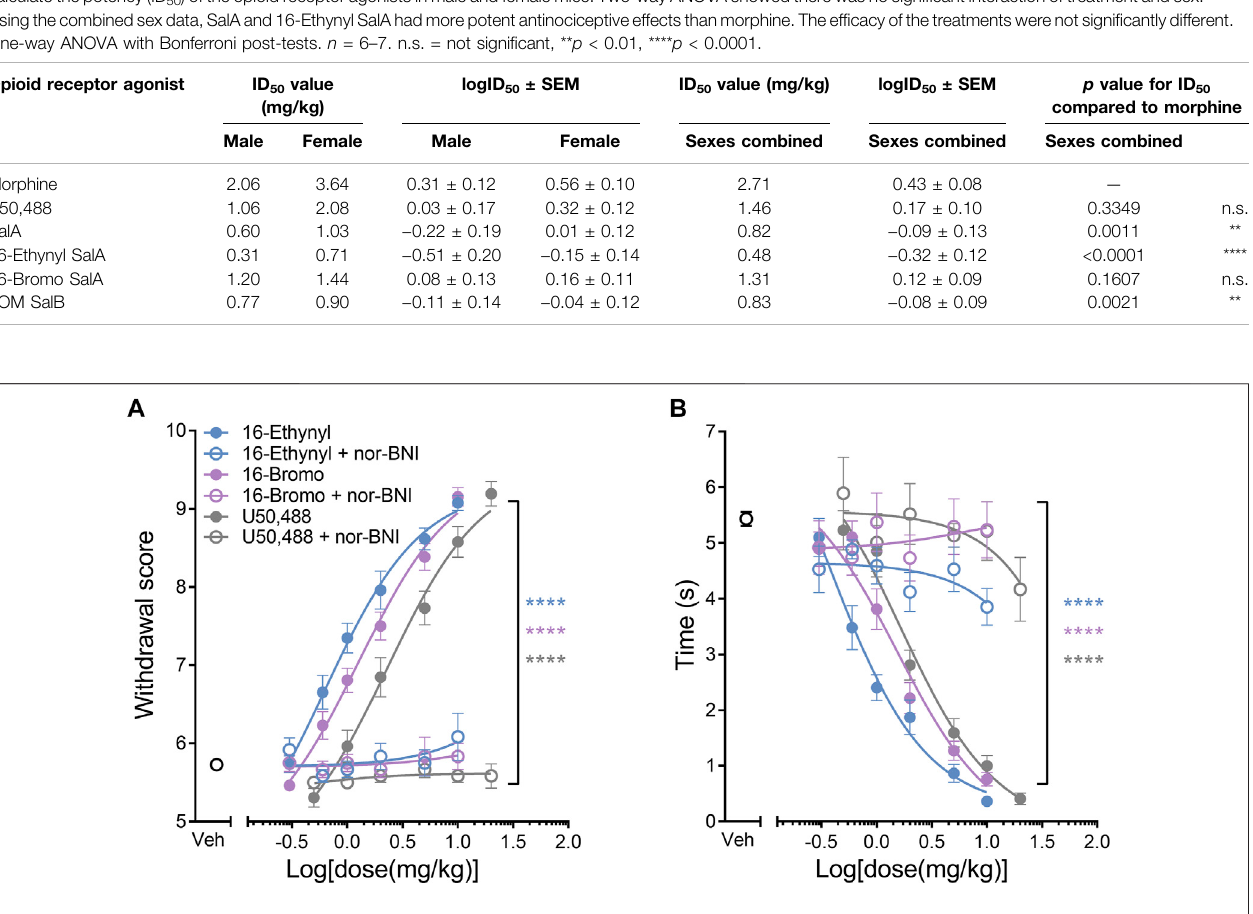
Frontiers in Pharmacology |